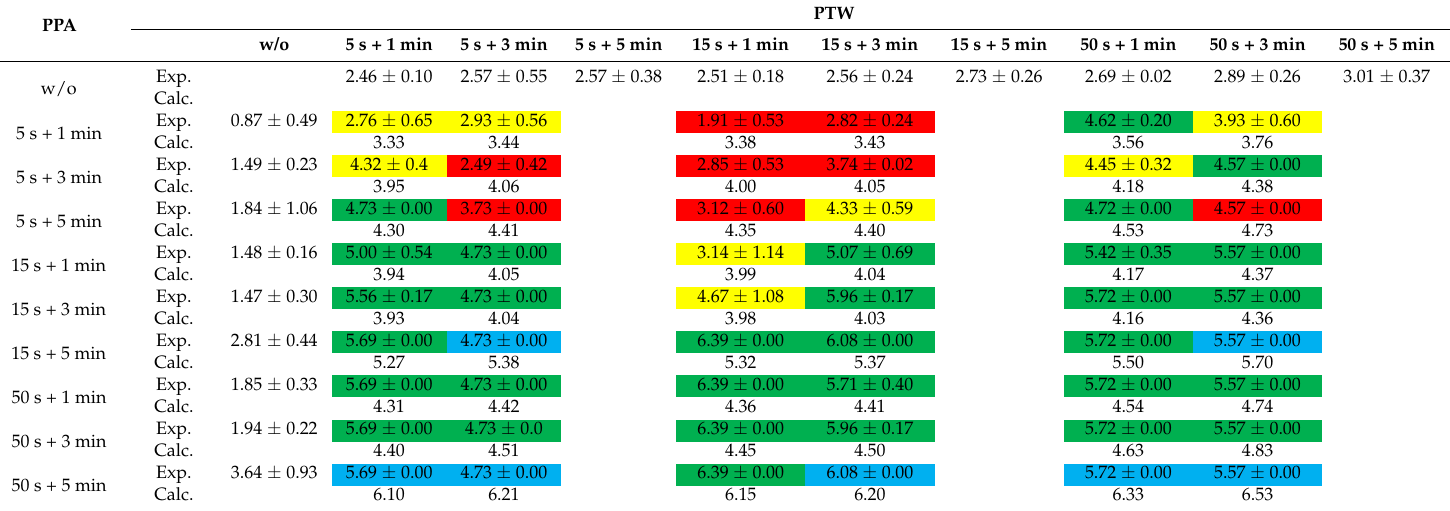
15 s + 5 min 50 s + 1 min 50 s + 3 min